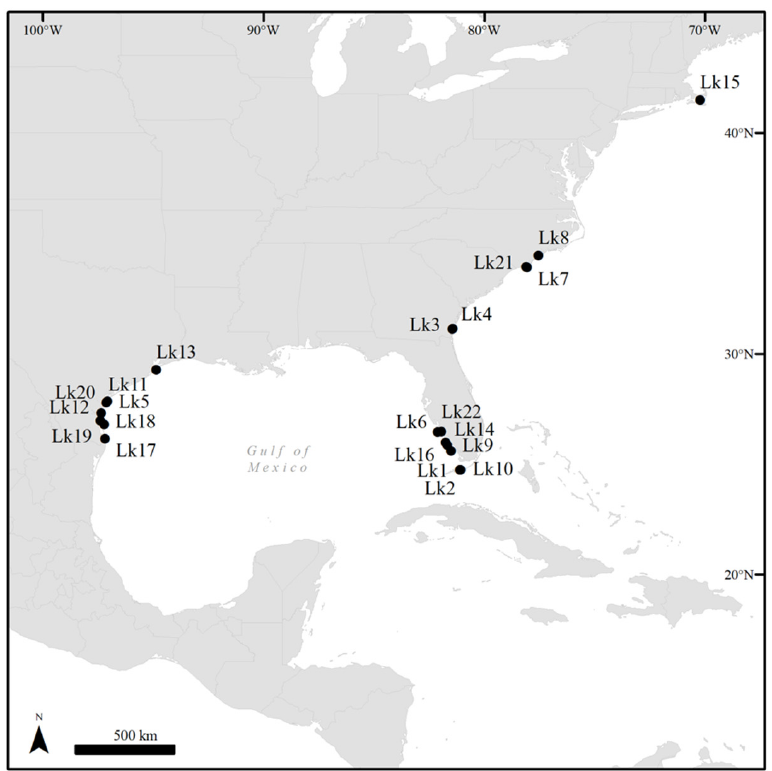
Figure 1. Locations of 22 cases of Kemp’s ridley sea turtles ( Lepidochelys kempii ) observed with fibropapillomatosis in the coastal United States during 2006–2020. Ten turtles (45.5%) had verrucous, arborizing masses (e.g., Figure 2a–e), one (4.5%) had flat plaques, and eleven (50.0%) had smooth, pedunculated masses (e.g., Figure 2f–h). Fibropapillomatosis was diagnosed in twelve turtles (54.5%) based on pathognomonic gross features (i.e., cutaneous fibroepithelial tumors), and in nine turtles (40.9%) based on